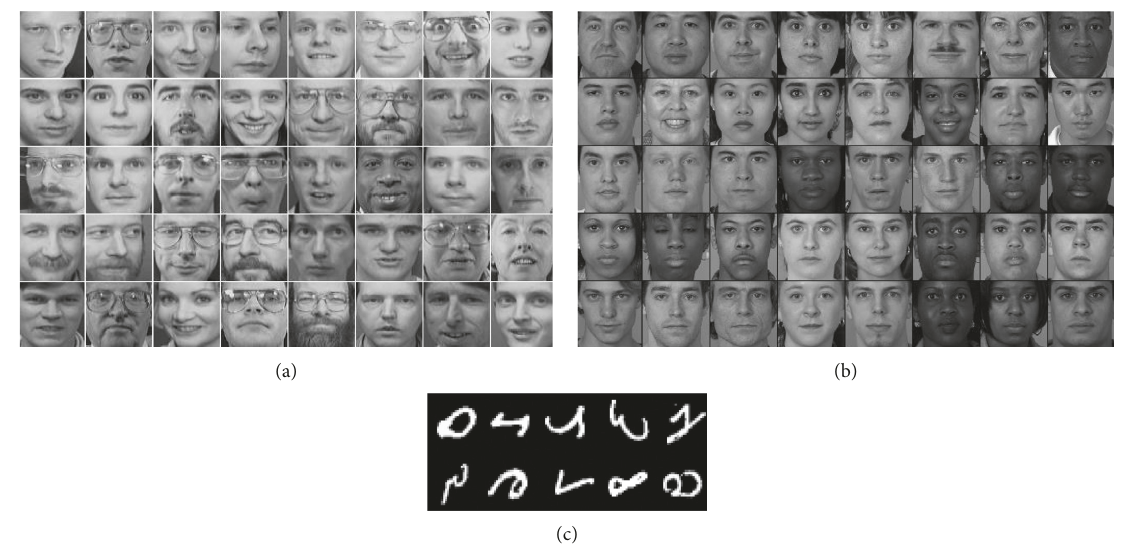
Figure 1: Example images of (a) ORL, (b) FERET, and (c) UCI